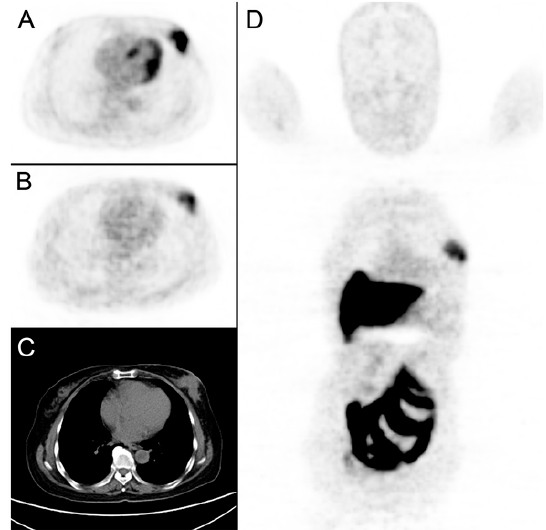
Figure 6. An example of a breast cancer patient receiving both [ 18 F]FDG and [ 18 F]FES-PET/CT scans prior to neoadjuvant chemotherapy. A : A tumor was detected in left breast with [ 18 F]FDG SUV max at 18 F]FES SUV 13.51. B and D : [ 18 F]FES SUV max at 4.3. C : CT imaging with the tumor diameter measured at 5.3 cm. 13.51. ( B , D ): [ max at 4.3. ( C ): CT imaging with the tumor diameter measured at 5.3